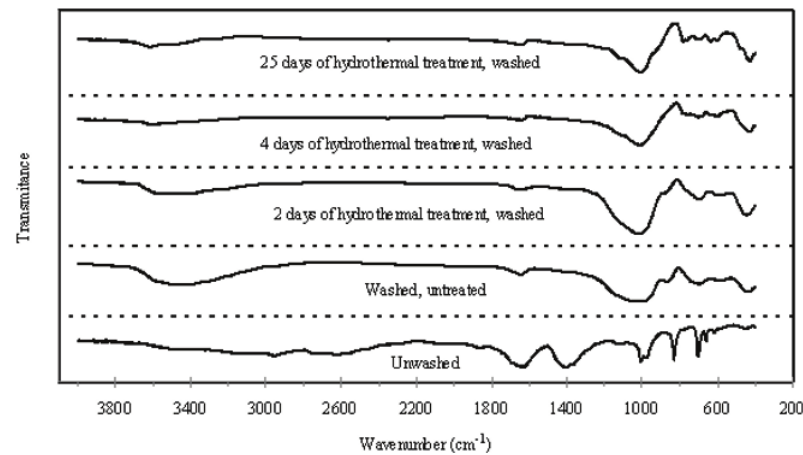
Figure 1. Comparison of the FTIR spectra of unwashed, washed and hydrothermally treated samples.